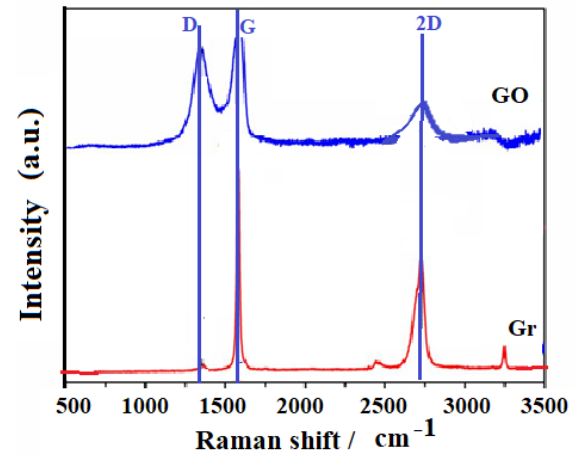
Figure 6. Raman spectra for graphite (Gr) and graphene oxide (GO).